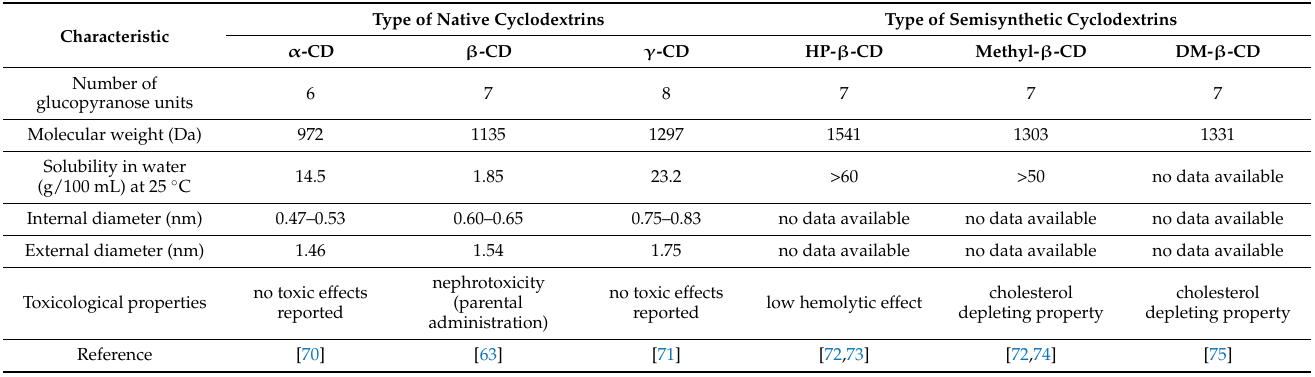
Table 2. Physicochemical and toxicological properties of